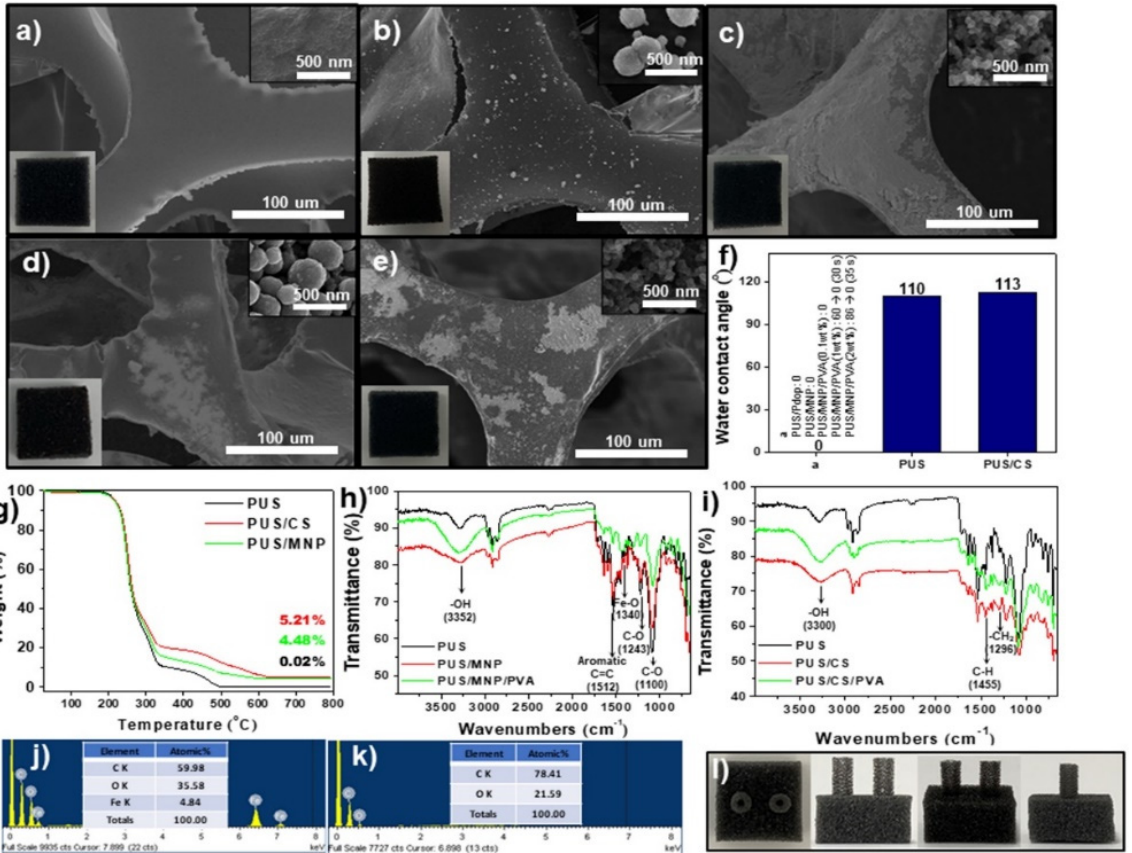
Figure 2. SEM data for the ( a ) PUS, ( b ) PUS/MNP, ( c ) PUS/CS, ( d ) PUS/MNP/PVA, and ( e ) PUS/CS/PVA. (Inset) Corresponding images of ( a – e ). ( f ) WCAs of various samples. ( g ) TGA data for PUS, PUS/CS, and PUS/MNP. FT-IR data for the ( h ) PUS/MNP/PVA and ( i ) PUS/CS/PVA. EDX data for the ( j ) PUS/MNP/PVA and ( k ) PUS/CS/PVA. ( l ) Images of the RPSs.